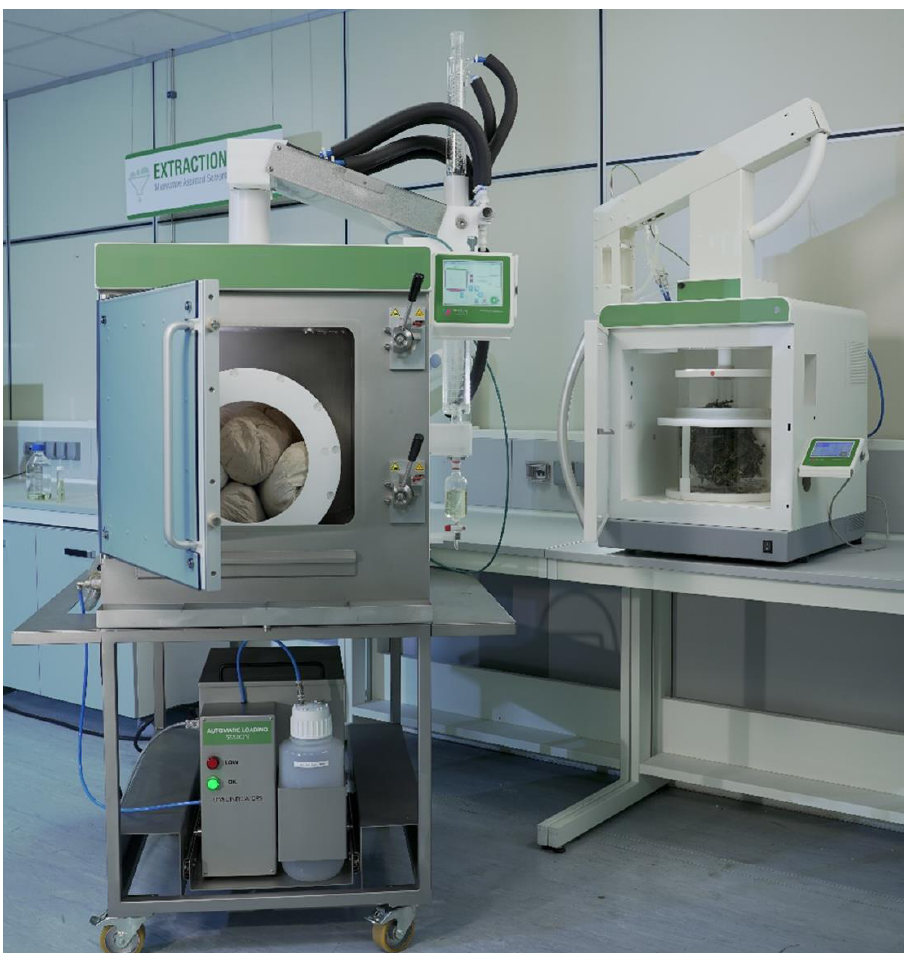
Figure 1. ETHOS X (right) and an ETHOS XL (left) extractors (Milestone srl, Bergamo, Italy).